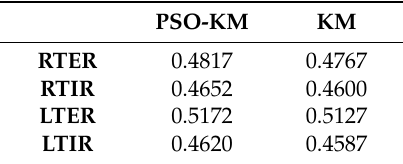
Table 7. The Rand Index values for the PSO-KM and the KM